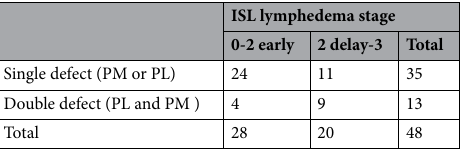
Table 5. The relation between single or double defect and lymphedema